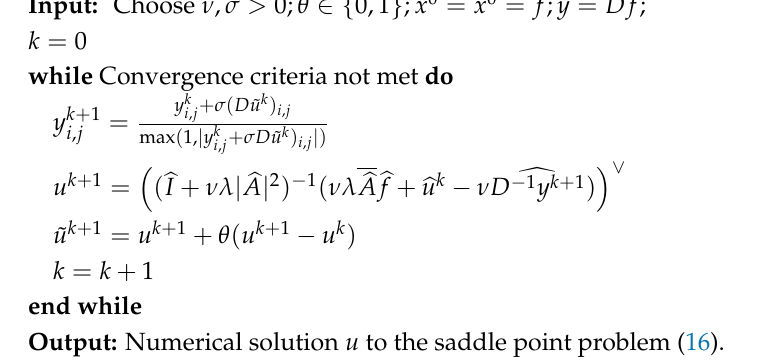
Algorithm 4 Wavelet based